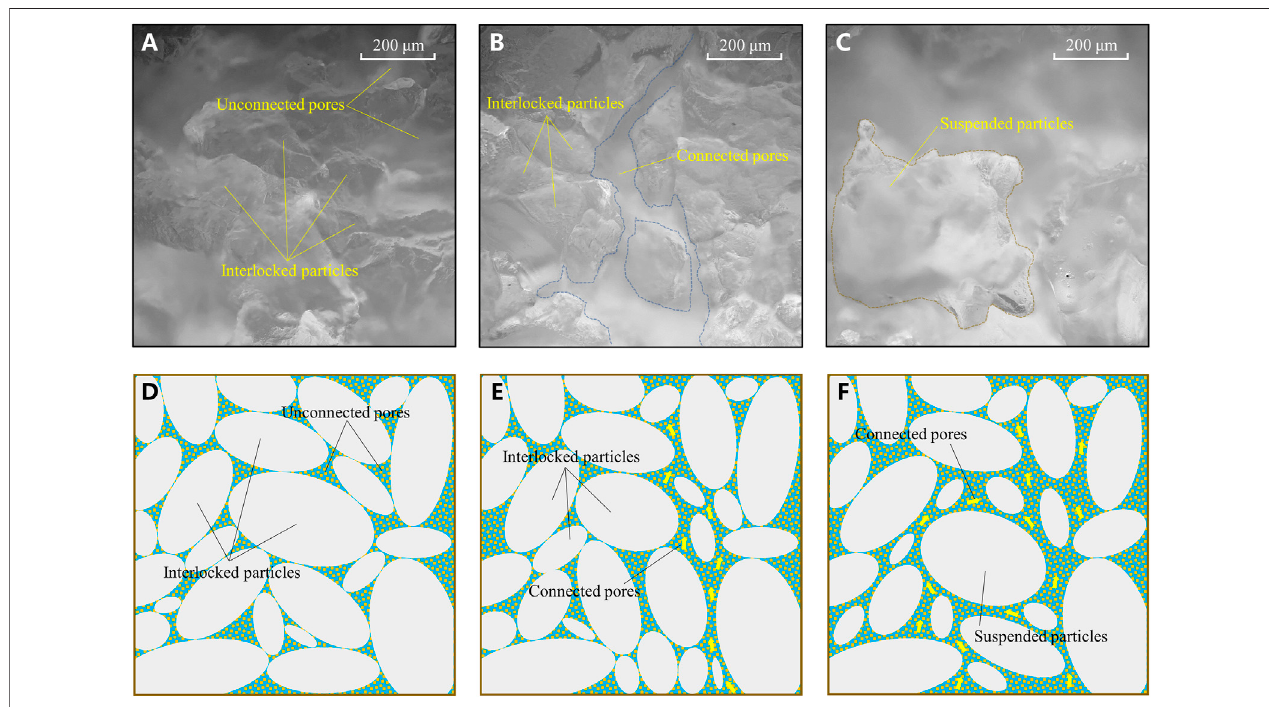
FIGURE 9 | Mesoscopic characteristics of TCS with mass ratios of silica powder of 5% (A – D) , 10% (B – E) and 15% (C – F) .